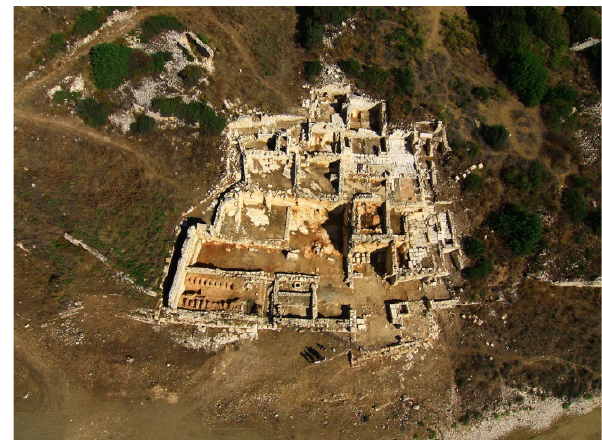
Figure 3. The residential district of Elaiussa